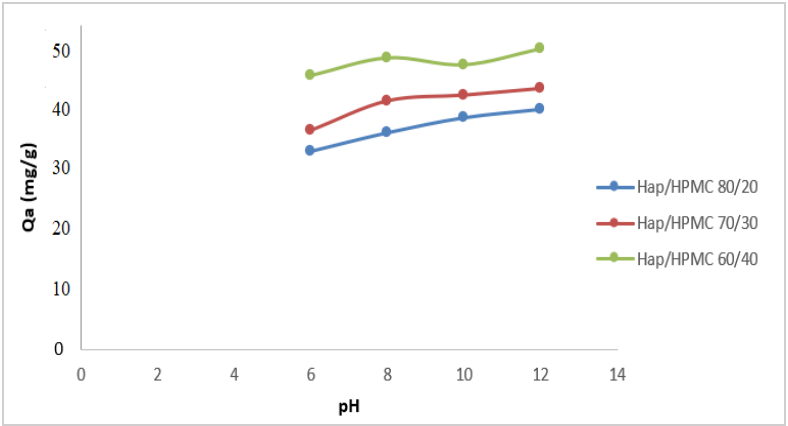
Figure 12. Effect of pH on the adsorption efficacy of the composites, [MB] = 53.5 mg/L and T = 25 ± 2 °C and V rot = 250 rpm. T = 25 ± 2 ◦ C and V rot = 250